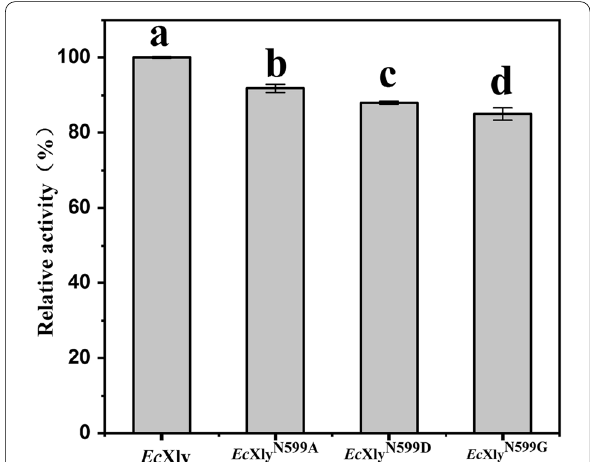
Fig. 6 The comparison of enzyme activity between Ec Xly and its mutants. The data represented the averages Each experiment was repeated three times. The significant difference was indicated by different letters ( P <